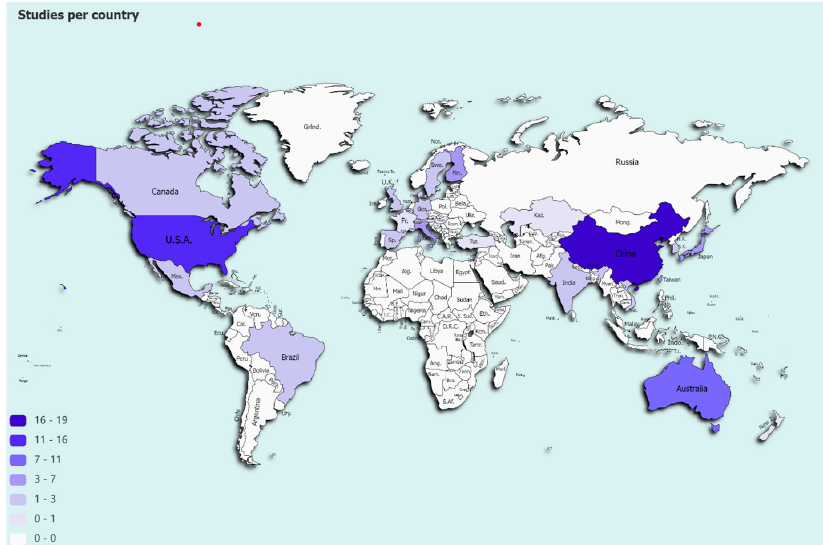
Figure 3. Global distribution of studies. Note: white color corresponds to missing studies in that country. Created with: paintmaps.com, accessed on 10 October 2022 Hospital admission ( n = 34) and completed suicide ( n = 34) were found to be the most